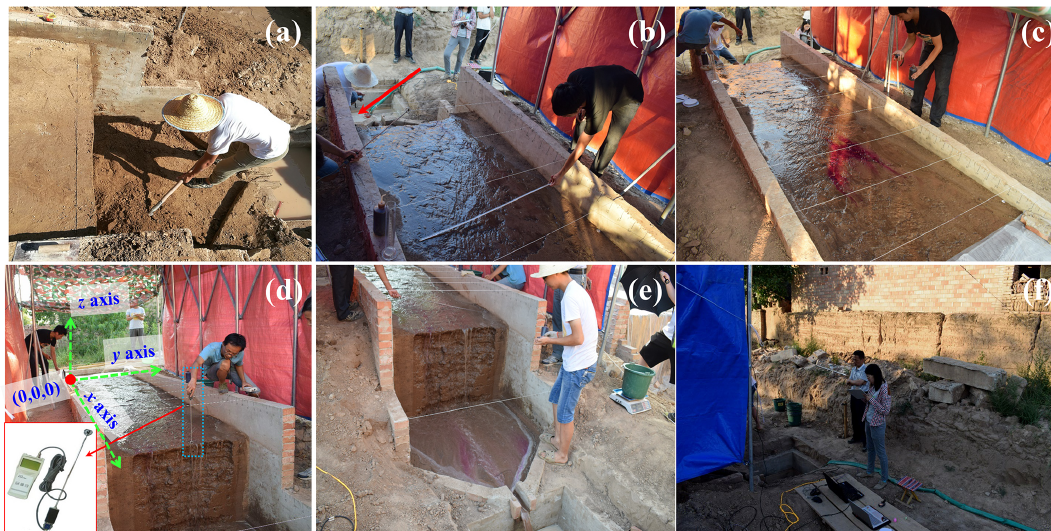
Figure 2. Plot construction (a) . Runoff width measurement of loess tableland and runoff and sediment sampling of outlet (b) . Runoff velocity measurement of loess tableland (c) . Jet velocity measurement of the gully head (d) . Runoff velocity and width measurement of the gully bed (e) . Experimental process recoding (f) .